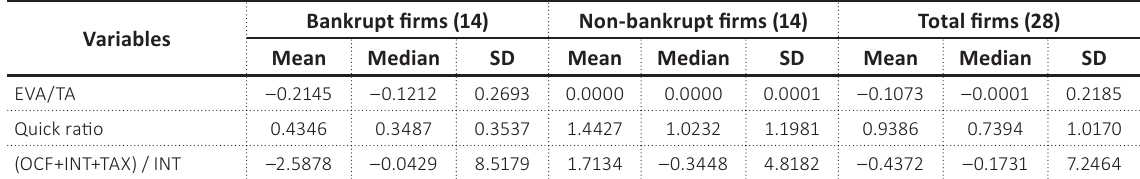
Table 7. Descriptive group statistics ( t –2)